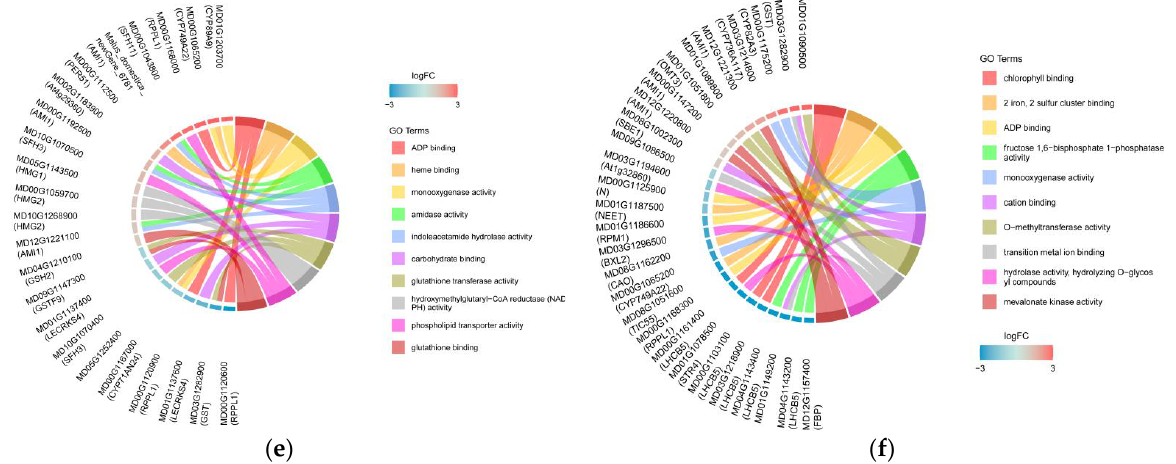
Figure 4. Enrichment string diagram of three DEGs from the ten most significantly enriched GO terms. ( a , b ) Biological process enrichment string diagram of BS vs. MS and BR vs. MR, respectively. ( c , d ) Cellular component enrichment string diagram of BS vs. MS and BR vs. MR, respectively. ( e , f ) Molecular function enrichment string diagram of BS vs. MS and BR vs. MR, respectively. (DEG IDs (name) on the left, each gene’s corresponding color is log 2 FC; the GO terms functional annotation on the right, different colors represent various GO terms).